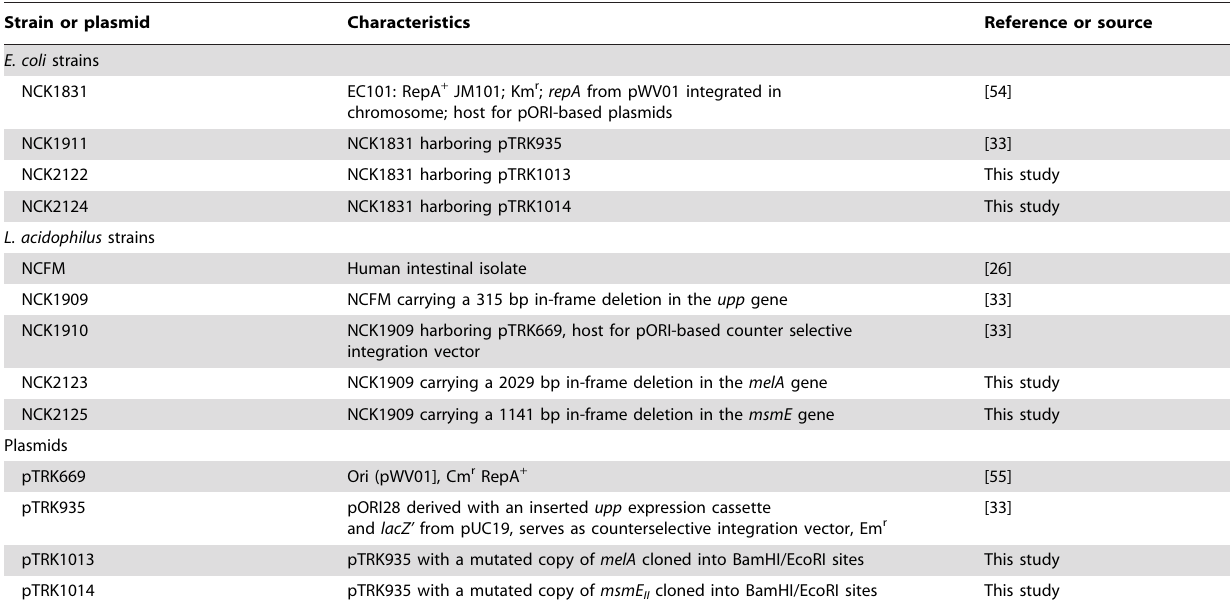
Table 3. Strains and plasmids used in the